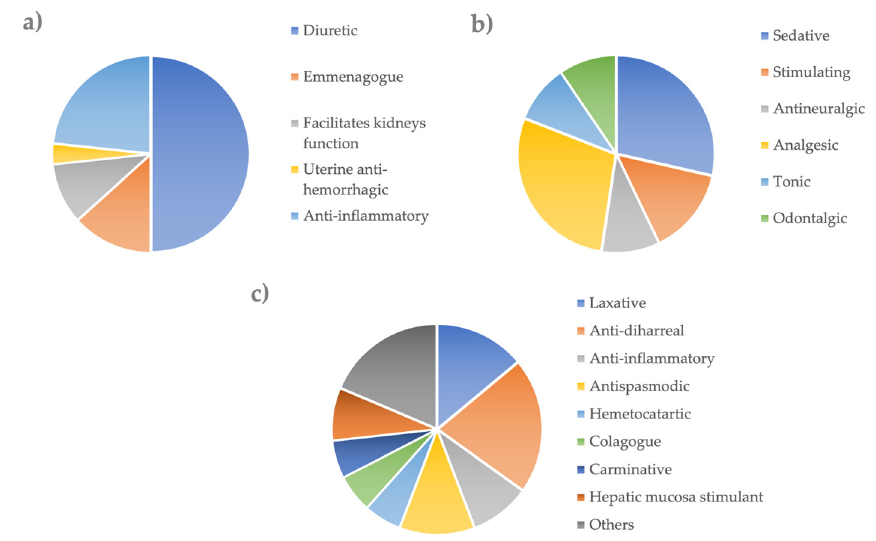
Figure 5. Folk therapeutical uses. The effects at the Urogenital ( a ), Nervous ( b ), and Digestive sys- tem ( c